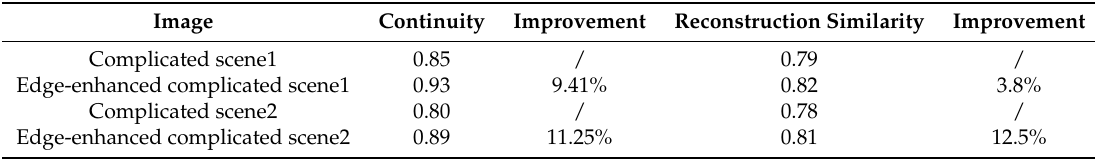
Table 3. Unsupervised evaluation of edge